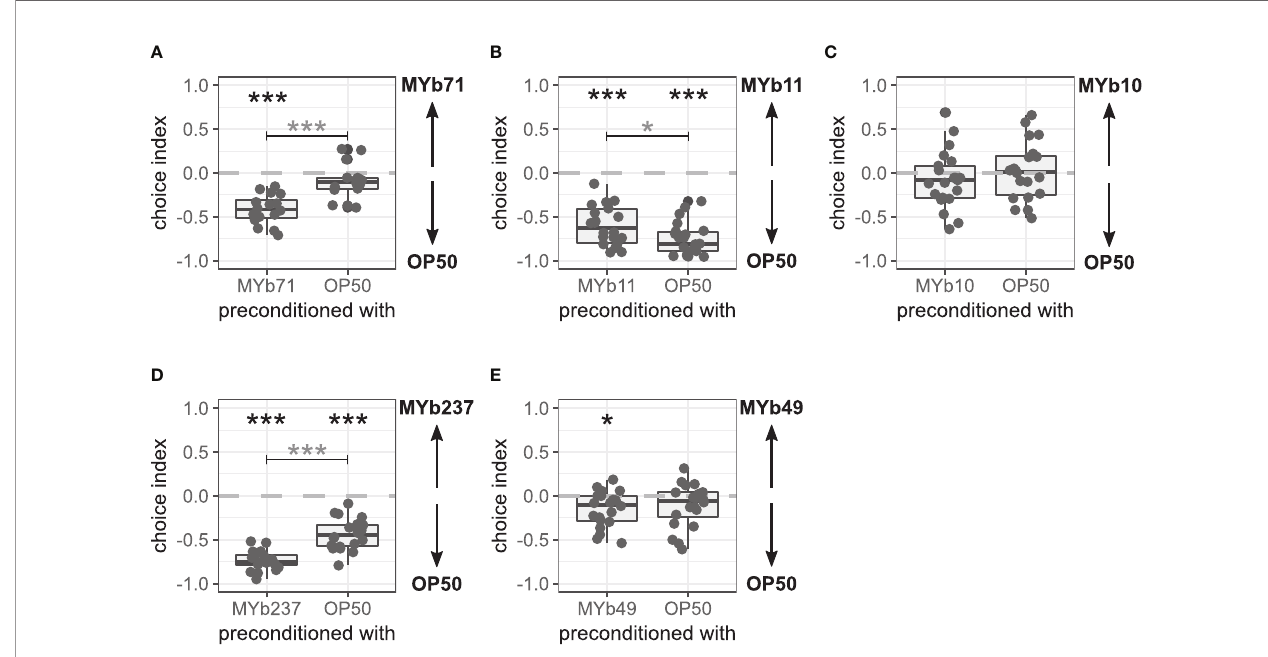
FIGURE 3 | Late microbiota avoidance response of Caenorhabditis elegans after bacterial preconditioning is species-speci fi c. Choice behavior of C. elegans MY2079 2 h after preconditioning with (A) OP50 or microbiota Ochrobactrum vermis MYb71 (n = 16, with ~70 worms per n), (B) Pseudomonas lurida MYb11 (n = 22, with ~70 worms per n), (C) Acinetobacter guillouiae MYb10 (n = 22, with ~70 worms per n), (D) Ochrobactrum pseudogrignonense MYb237 (n = 20, with ~70 worms per n), or (E) Ochrobactrum anthropi MYb49 (n = 20, with ~70 worms per n). Additional runs are shown in Supplementary Figure S3 . Wilcoxon signed- rank test with false discovery rate (FDR) correction for multiple testing was applied for comparing the choice indices to 0. Data are presented in boxplots; each gray dot represents one replicate. A negative choice index indicates a choice of OP50, a positive choice index indicates a choice of the microbiota, and a choice index of 0 indicates the equal choice of both bacteria. Asterisks indicate a difference to a choice index of 0 (black) or a difference between preconditioning treatments (gray). Signi fi cance is designated to the following scale: *** p < 0.001, * p < 0.05.